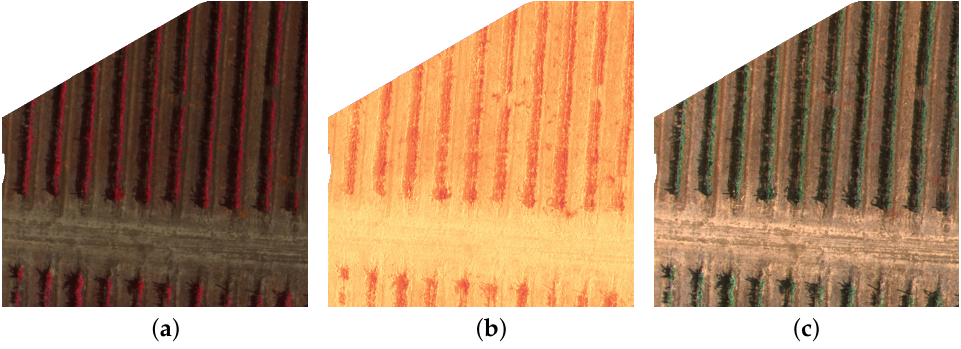
Figure 3. Example of cropped images from the same map in different multi-spectral indices. All 3 images share the same name in their respective datasets. ( a ) CIR, ( b ) NDWI, ( c )